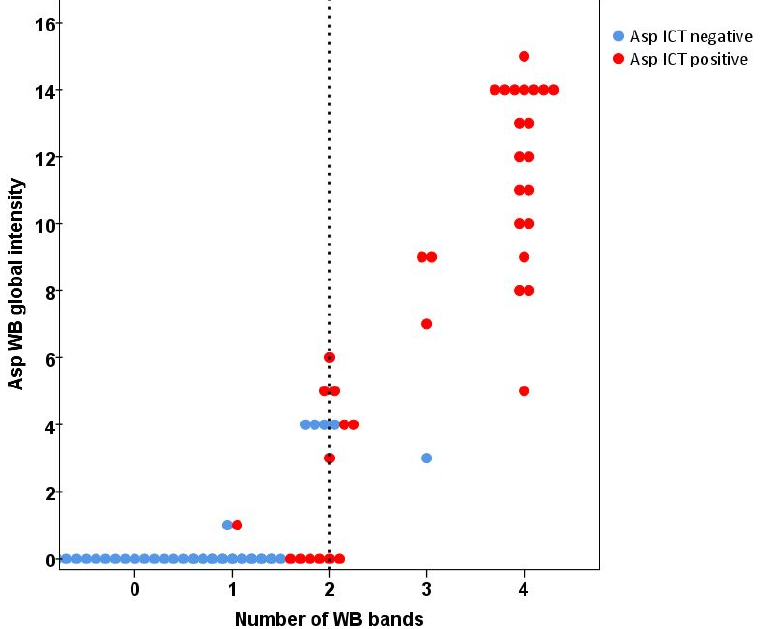
Figure 3. The scatterplot of Aspergillus IgG banding patterns in correlation with WB global intensity and Asp ICT results with minimum number of WB bands (2) indicated positive results showed as a dash line. There was a substantial agreement between ICT and WB (Cohen’s Kappa 0.716 (95% CI 0.567–0.864)).